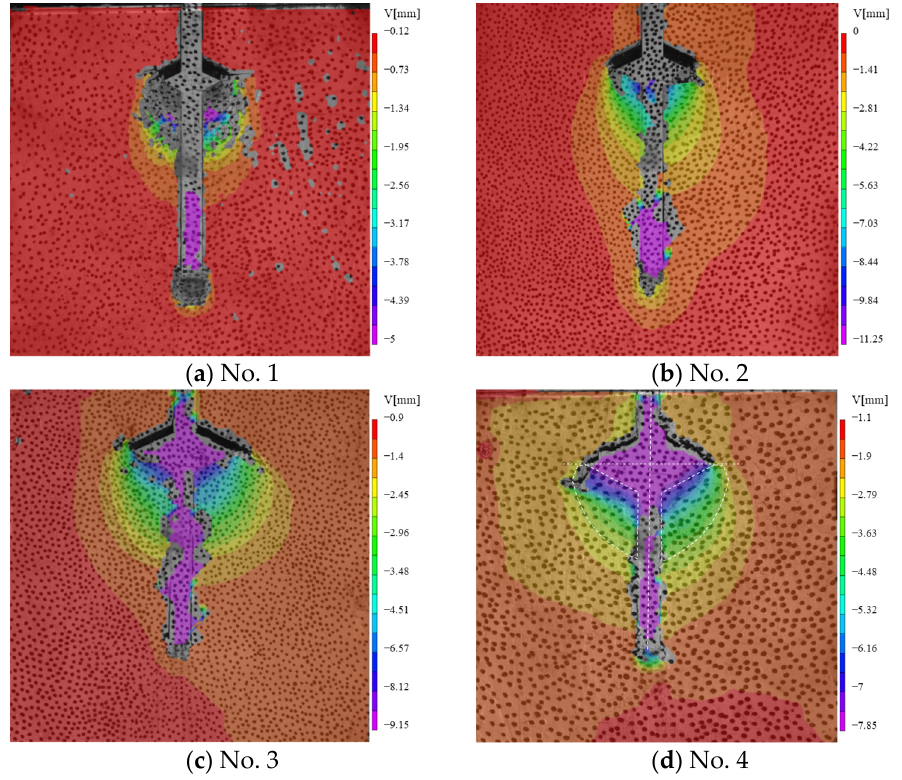
Figure 14. The vertical displacement of soil surrounding the pile (load: 0.8 kN). It is shown in Figure 14 that when the load is 0.8 kN, a void is created due to the separation between the expanded body and the upper soil, and the height of the void decreases with the increasing diameter of the expanded body. In Figure 14a, the soil below the expanded body was crushed (including the soil at the bottom), and the main in fl uence